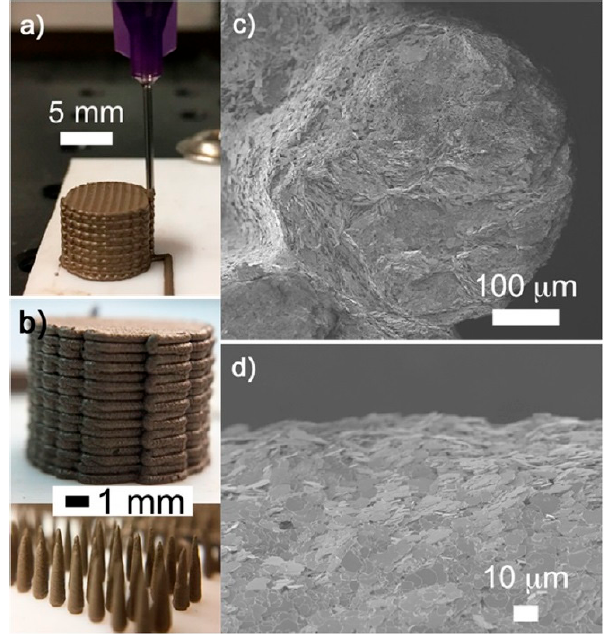
Figure 25. Printed objects from GO/Al 2 O 3 platelets paste ( a ) and ( b ) and cross-section and lateral view of printed filament ( c ) and ( d ). Reproduced from [29], with permission from American Chemical Society, 2017.